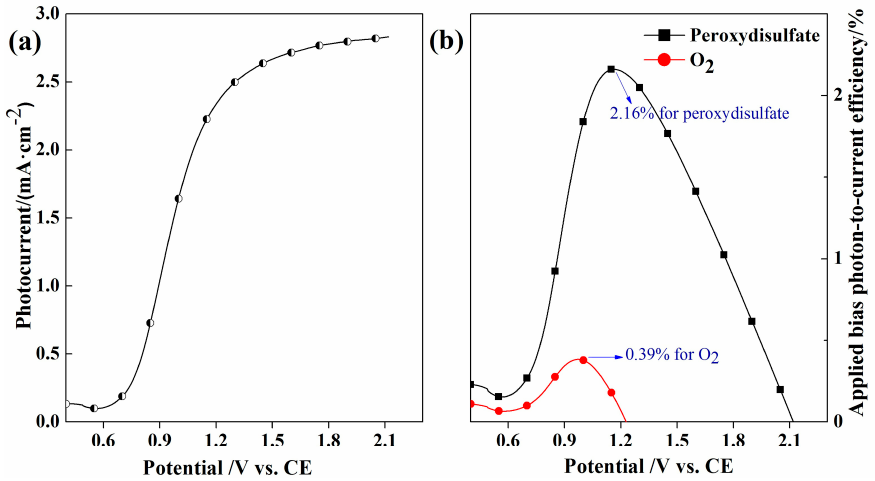
Figure 5. ( a ) The photocurrent and ( b ) the applied bias photo ‐ current efficiency in a 1.0 M Na 2 SO 4 aqueous solution (pH = 2) by using a WO 3 photoanode under illumination of simulated solar